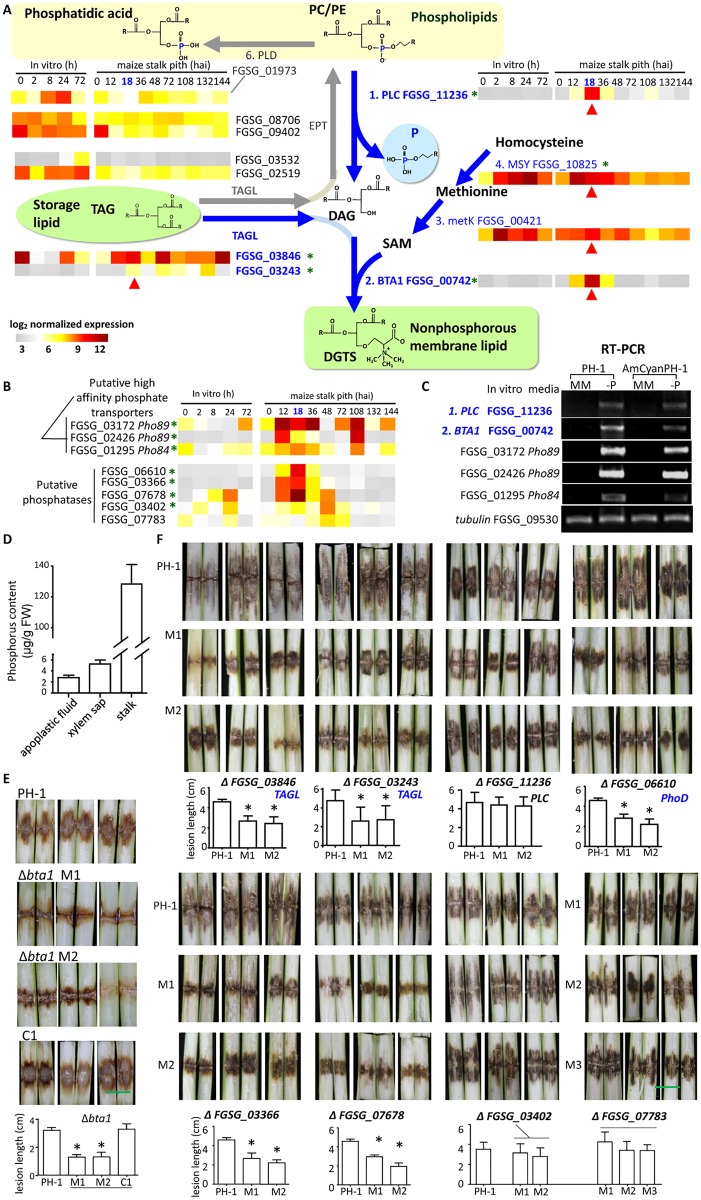
Expressional and functional analysis of genes potentially related to non-phosphorus membrane lipid biosynthesis and phosphate metabolism.(A) Diagram illustrating reactions related to the interconversion of lipids, and the expression of related genes. Heat maps indicate the expression of individual genes from microarray data. h: hour. hai, hours after inoculation. (B) Heat maps of genes related to phosphate transport and metabolism. Red arrows point to 18 hai, green asterisks indicate gene expression significantly up-regulated in maize infection compared to in vitro growth (SAM FDR < 0.05). (C) RT-PCR analysis of in vitro grown F. graminearum. MM: minimal medium, −P: minimal medium lacking phosphate. (D) ICP-MS measurements of phosphorus contents in various fractions of maize stalk. (E)-(F) Maize stalk infection assays. Lesions were diagnosed at 7 days post inoculation. *Significantly different difference from wild type-caused lesion (Student’s t-test, P <0.05), n = 3 independent experiments. Error bars denote SE. PC: phosphatidylcholine, PE: phosphatidylethanolamine, TAGL: triacylglycerol lipase, DAG: diacylglycerol, SAM: S-adenosylmethionine, DGTS: betaine lipid diacylglyceryl-N,N,N-trimethylhomoserine, PLC: phospholipase C, PLD: phospholipase D, MetK: methionine adenosyltransferase ETH-1, MSY: methionine synthase, EPT: ethanolamine-phosphotransferase, BTA1: betaine lipid biosynthetic enzyme.